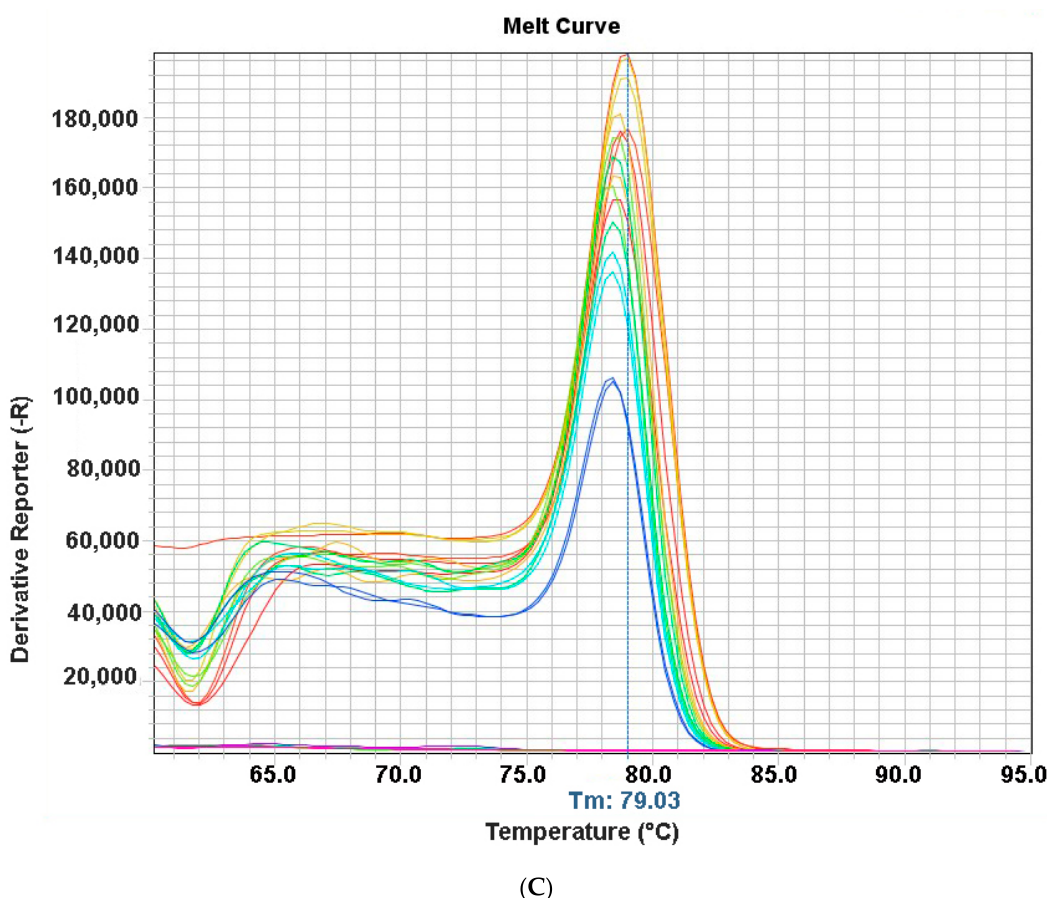
Figure 1. Sensitive real time fast-real time PCR (qPCR) based on SYBR ® Green for detection and quantification of non-structural (NS) gene of Chicken Parvovirus (ChPV)—( A ) Standard curve using 10-fold serial dilution of NS gene plasmid of ChPV; ( B ) Amplification Plot; ( C ) Melting Curve.